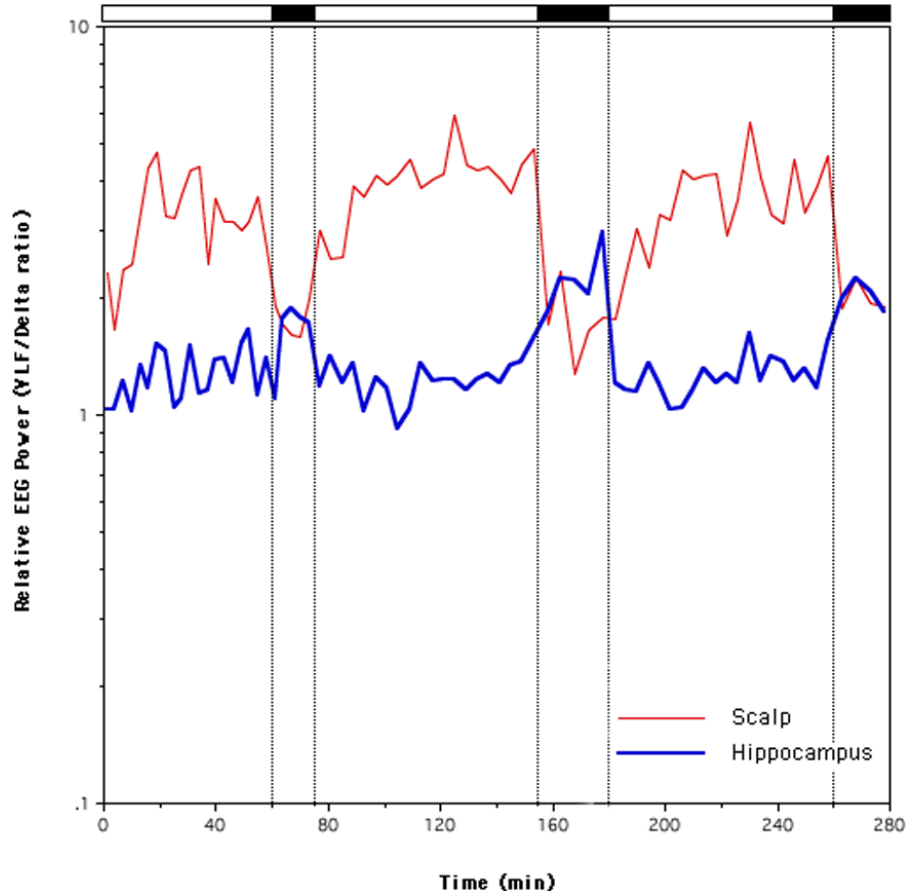
Figure 4. Time course of the very low frequency/delta power ratio (0.5–1.0/1.1–5.0 Hz) across the first three NREM-REM cycles, separately for scalp and hippocampal recordings. REM periods are indicated by the black bars on top of the figure.